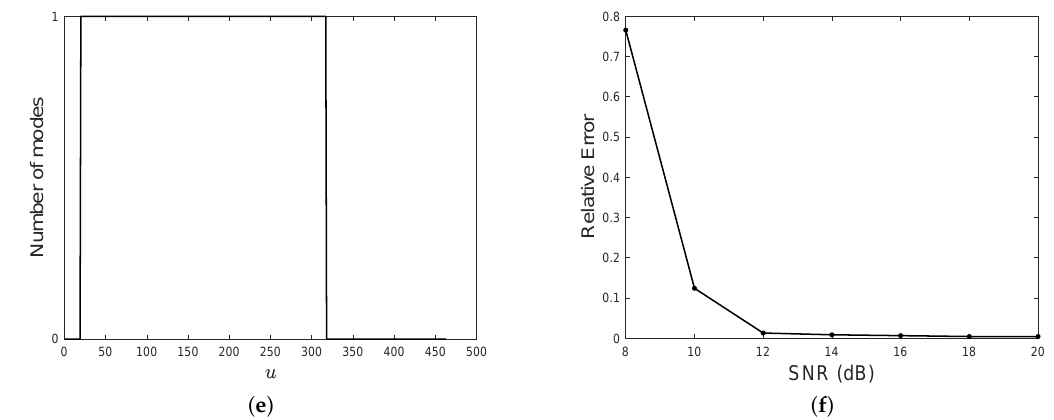
Figure 20. ( a ) Hyperbolic chirp embedded with AWG noise, SNR = 15 dB. ( b ) Spectrogram of ( a ), s = 46. ( c ) Optimal threshold provided by MDL functional minimization, according to Equation (18). ( d ) Binary map derived from ( b ). ( e ) Estimated number of modes. ( f ) Relative counting error against SNR.